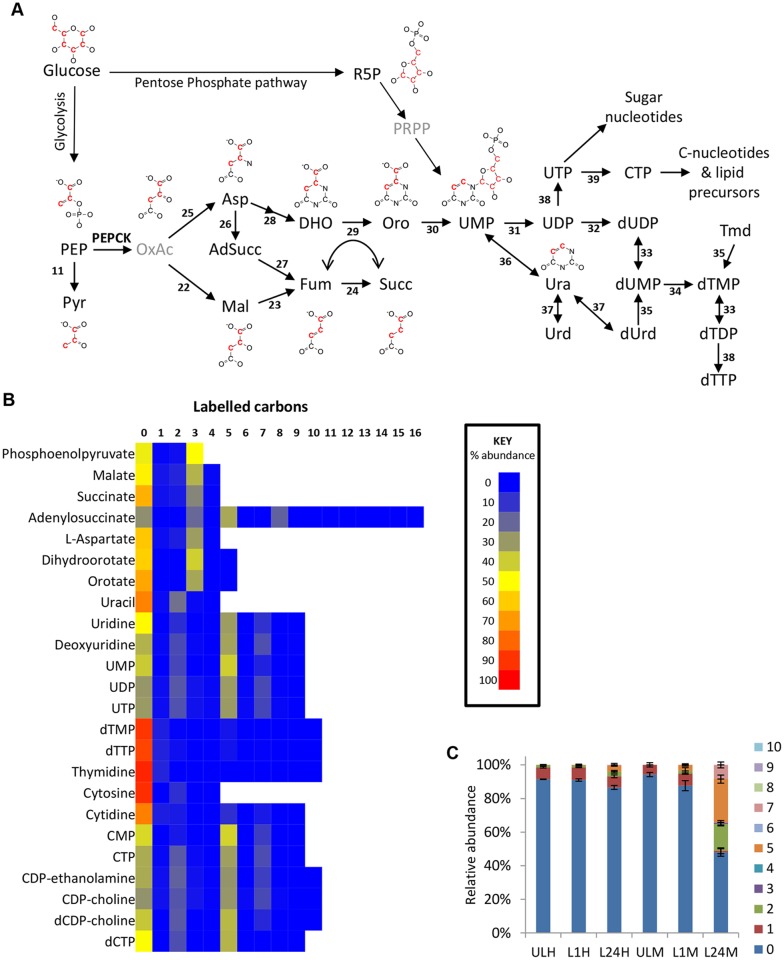
Glucose-derived dicarboxylic acid and pyrimidine metabolic pathways in BSF T. brucei indicate activity of PEPCK.(A) Metabolic pathways of dicarboxylic acid and pyrimidine synthesis in BSF T. brucei. Red carbons in structures indicate the predominant 13C labelling. (B) Heatmap of relative isotopologue abundances for dicarboxylic acid and pyrimidine intermediates after labelling for 24 hours with 50% U-13C-glucose in HMI11. (C) Isotopologue abundances of dTTP after labelling for 0 (U), 1 (L1) and 24 (L24) hours with 50% U-13C-glucose in HMI11 (H) or CMM (M) (n = 2–3, mean ± SD). Extensive de novo dTTP synthesis was only observed in CMM (i.e. in the absence of exogenous thymidine). Abbreviation: PEP, phosphoenolpyruvate; Pyr, pyruvate; OxAc, oxaloacetate; Mal, malate; Fum, fumarate; Succ, succinate; Asp, Aspartate; AdSucc, adenylosuccinate; DHO, dihydroorotate; Oro, orotate; Ura, uracil; Urd, uridine; dUrd, deoxyuridine; Tmd, thymidine. Enzymes: 11, pyruvate kinase; 22, malate dehydrogenase; 23, fumarase; 24, NADH-dependent fumarate reductase); 25, aspartate aminotransferase; 26, adenylosuccinate synthase; 27, adenylosuccinate lyase; 28, aspartate carbamoyltransferase and dihydroorotase; 29, dihydroorotate dehydrogenase; 30, orotate phosphoribosyltransferase and orotidine 5-phosphate decarboxylase; 31, nucleoside diphosphatase; 32, ribonucleoside-diphosphate reductase; 33, thymidylate kinase; 34, thymidylate synthase; 35, thymidine kinase; 36, uracil phosphoribosyltransferase; 37, uridine phosphorylase; 38, nucleoside diphosphate kinase; 39, cytidine triphosphate synthase.